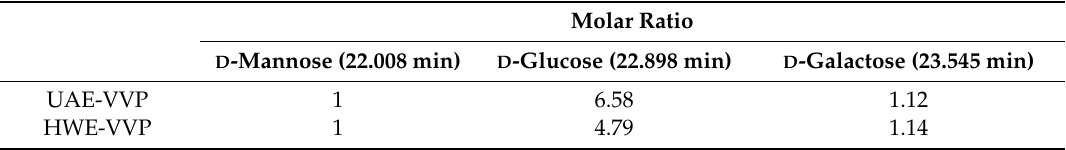
Table 2. Monosaccharide composition of VVP extracted with ultrasound-assisted extraction (UAE) and hot water extraction (HWE).